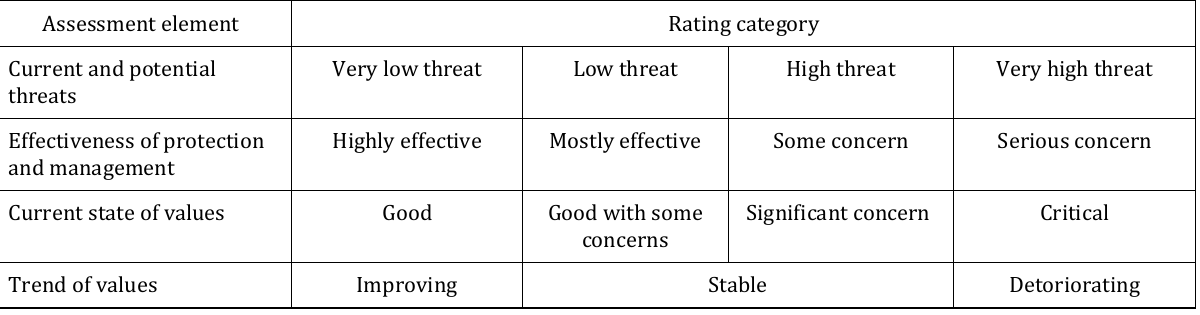
Table 1. Assessment of the conservation of the World Heritage sites